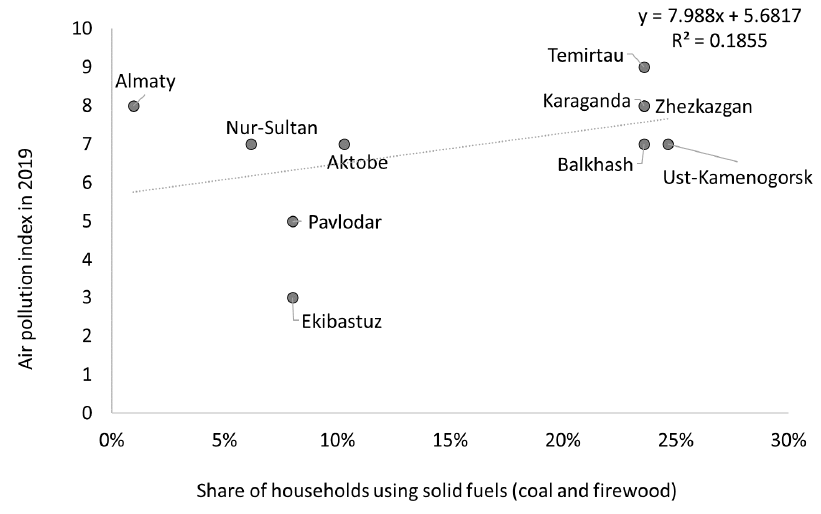
Figure 7. Share of households using coal and API in 2019.